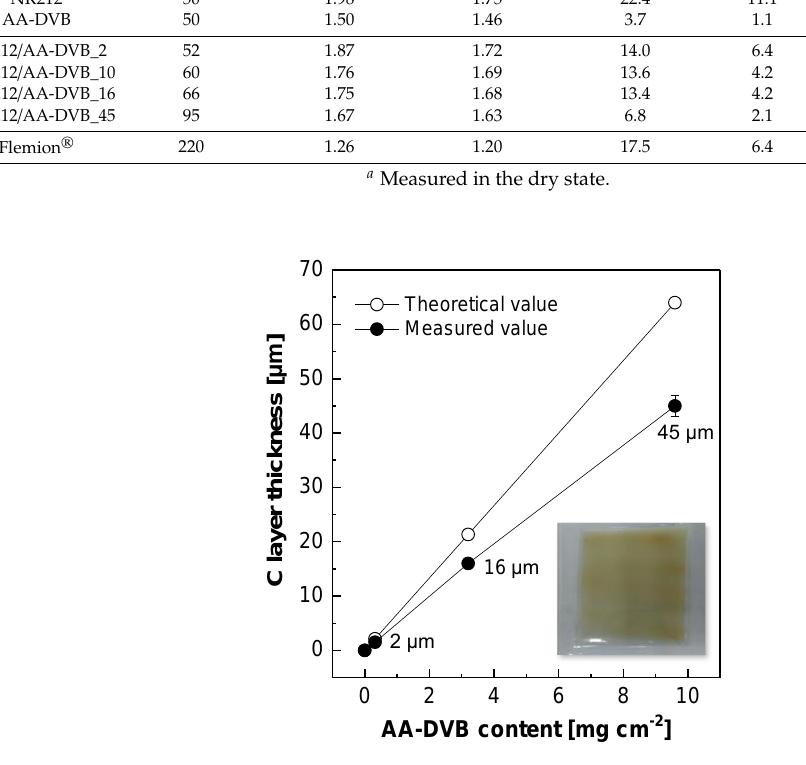
Figure 4. C layer thickness as a function of AA-DVB contents in double layered NR212/AA-DVB membranes.